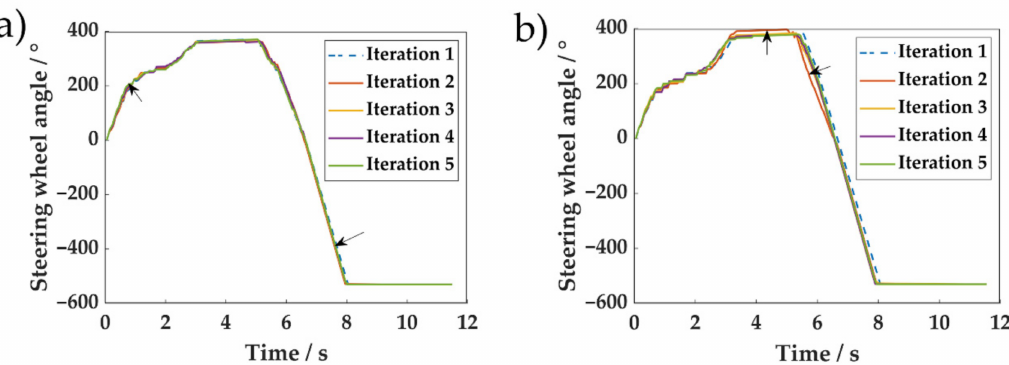
Figure 12. Steering wheel angle for each iteration at initial position (1.25 m, 1.5 m, 0) using di ff erent methods: ( a ) Steering angle for the proposed data-e ffi cient reinforcement learning; and ( b ) basic MCTS without re-weighting. The black arrows are the direction of the